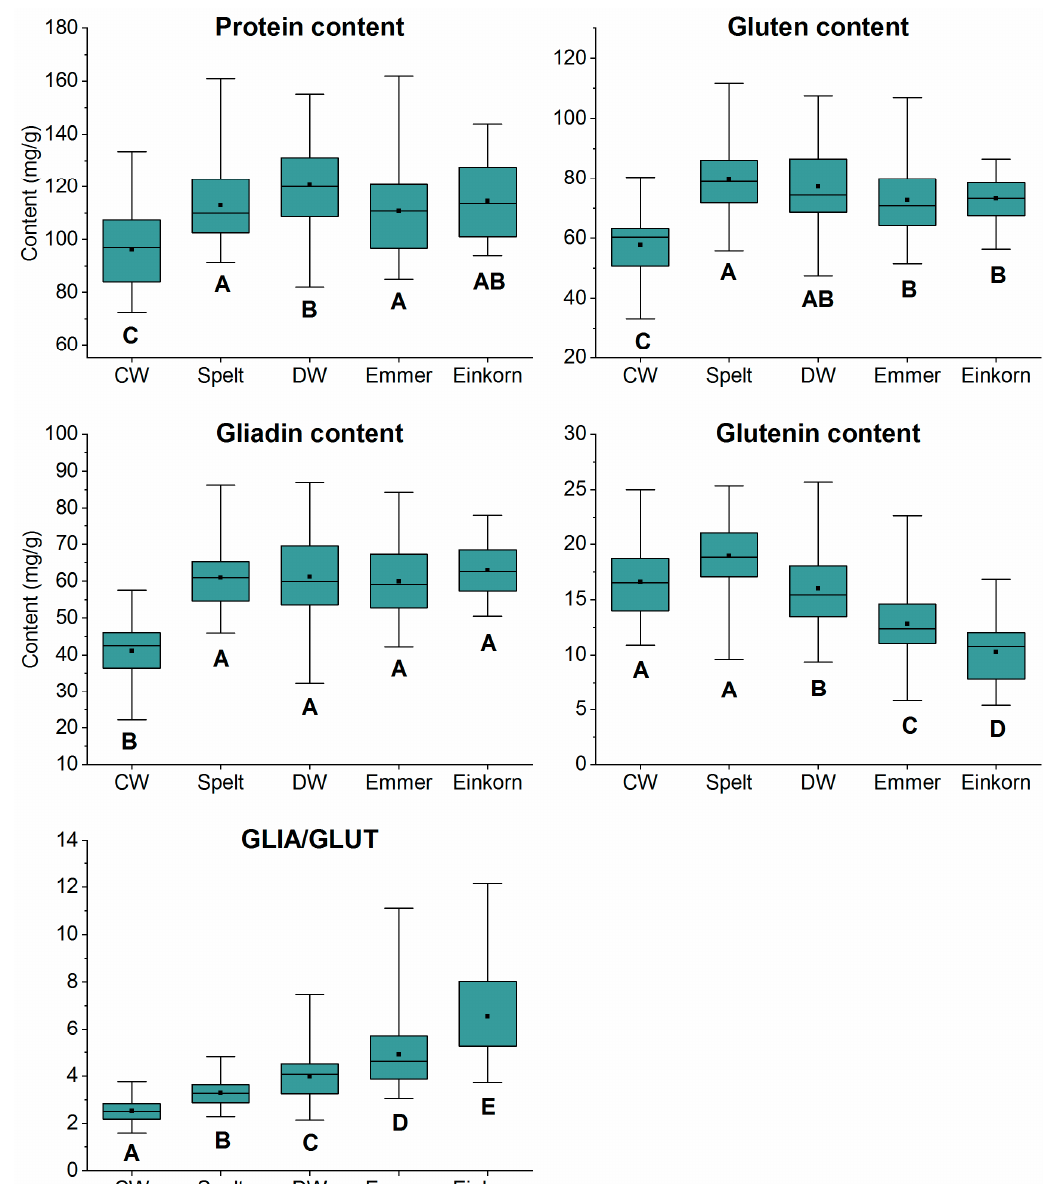
Figure 2. Contents of protein, gluten, gliadins, glutenins and the ratio between gliadins and glutenins (GLIA/GLUT) in common wheat (CW), spelt, durum wheat (DW), emmer and einkorn. Data are presented as median (line in the box) of 15 cultivars per wheat species cultivated at four locations (n = 60), boxes represent the interquartile range, the rectangle in the box represents the mean value, whiskers designate minima and maxima and different capital letters indicate significant differences between the wheat species (one-way analysis of variance (ANOVA), Tukey’s test at p < 0.05).